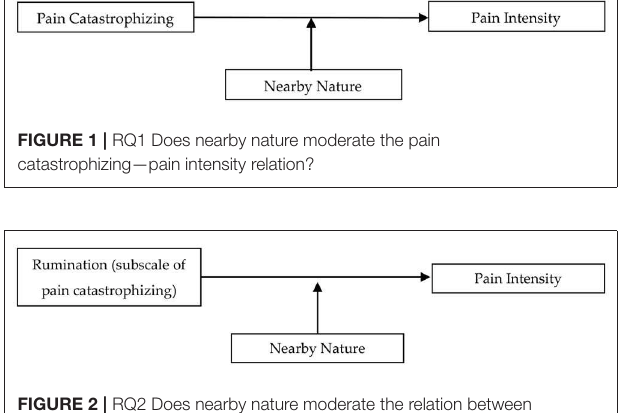
TABLE 1 | Participant socio-demographic